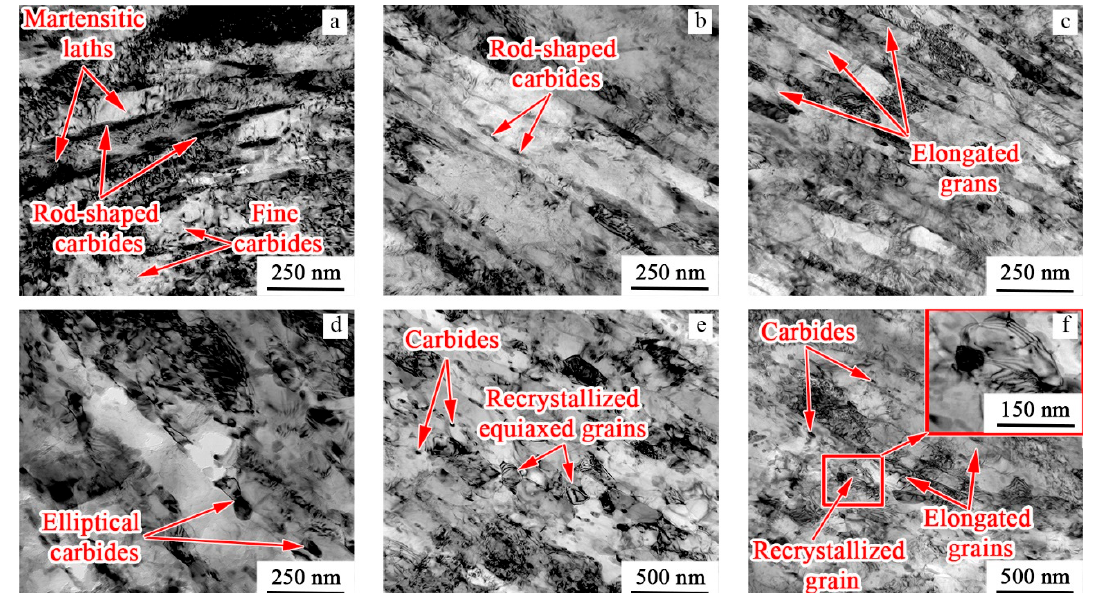
Figure 7. Transmission electron microscopy (TEM) photographs of fine structure after compression at 400 °C ( a–c ) and 500 °C ( d–f ) with strain rate of 1.3·10 − 3 s − 1 to different strain degrees ( ε ): 0 ( a, d ), 0.3 ( b ), 0.77 ( e ), 0.97 ( c ) and 1.15 ( f ). 0.3 ( b ), 0.77 ( e ), 0.97 ( c ) and 1.15 ( f